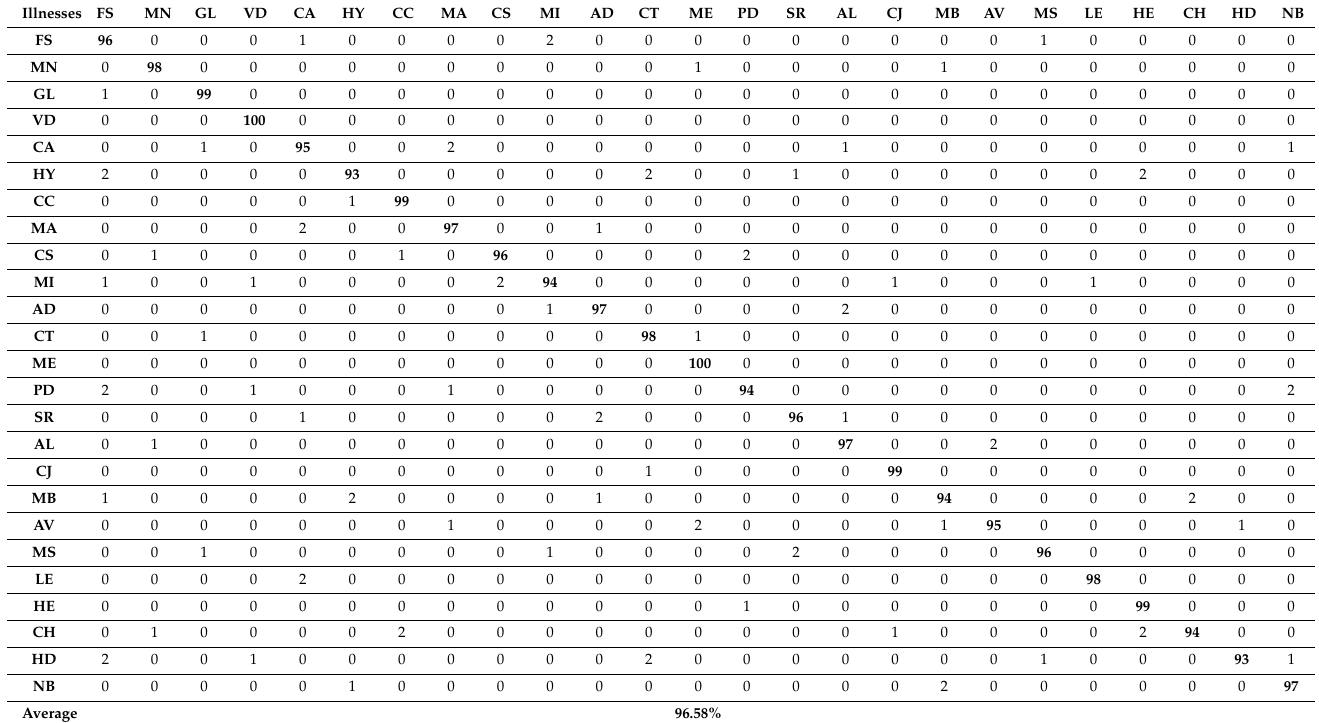
Table 1. Performance of the developed approach using MRI dataset (Unit